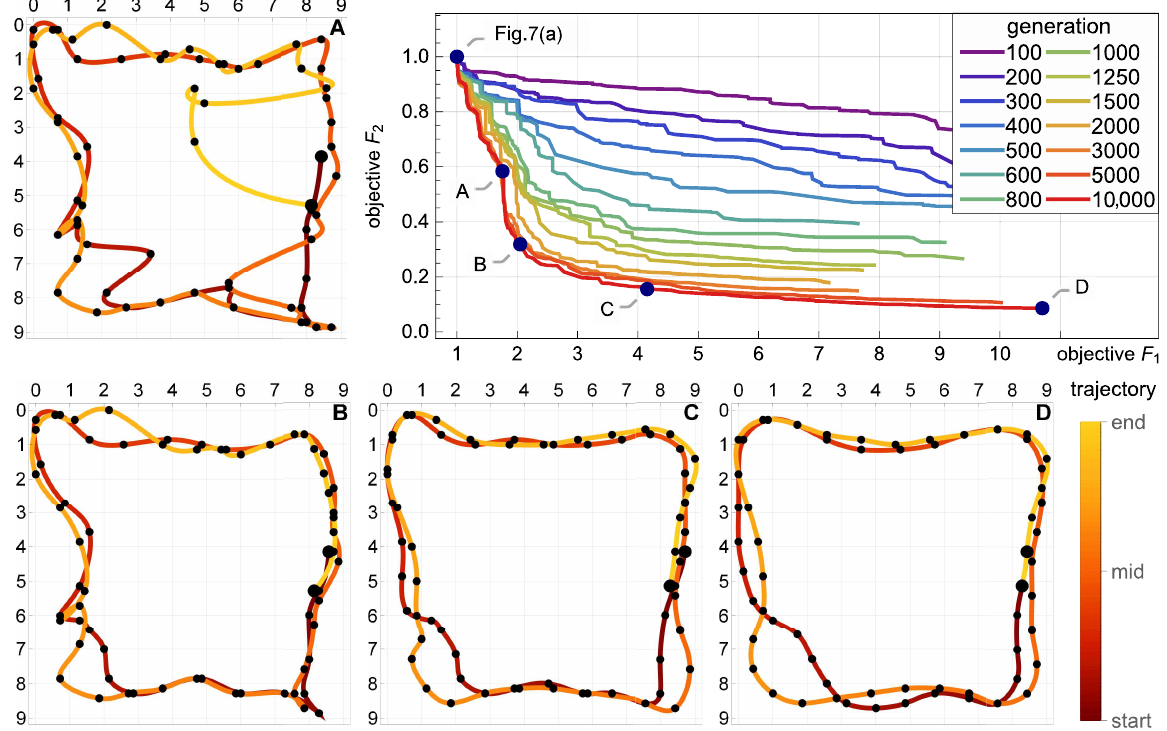
Figure 8. Multicriterial identification of the square trajectory: advancement of the Pareto front and four specific trajectories along the final front (A, B, C and D). The top left dot on the Pareto front corresponds to the trivial F 1 -optimum trajectory shown in Figure 7a. The actual trajectory is shown in Figure 2.